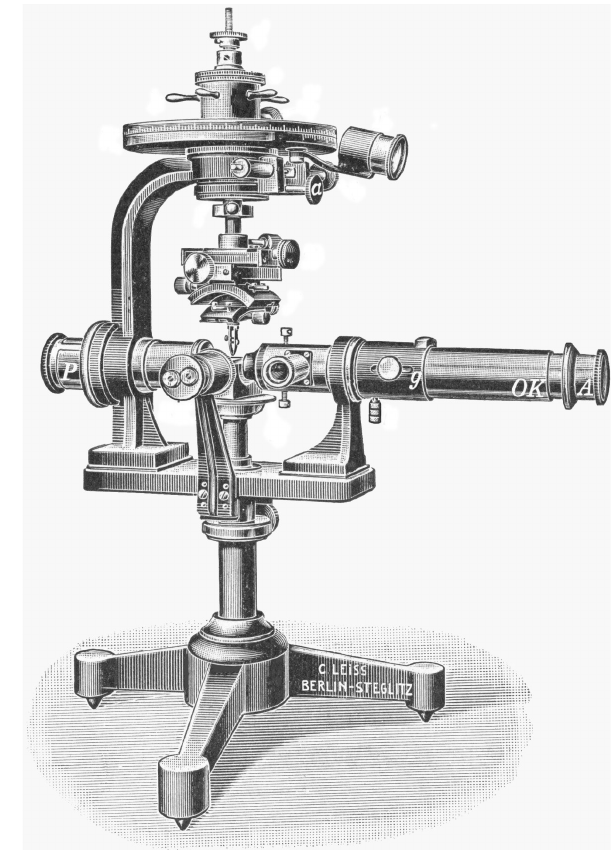
Figure 6. A specialized instrument for measuring the optical prop- erties of single crystals, designed by E. A. Wülfing. Nicol prisms are at P and A, in the outer ends of the horizontal tubes. Adapted from Leiss